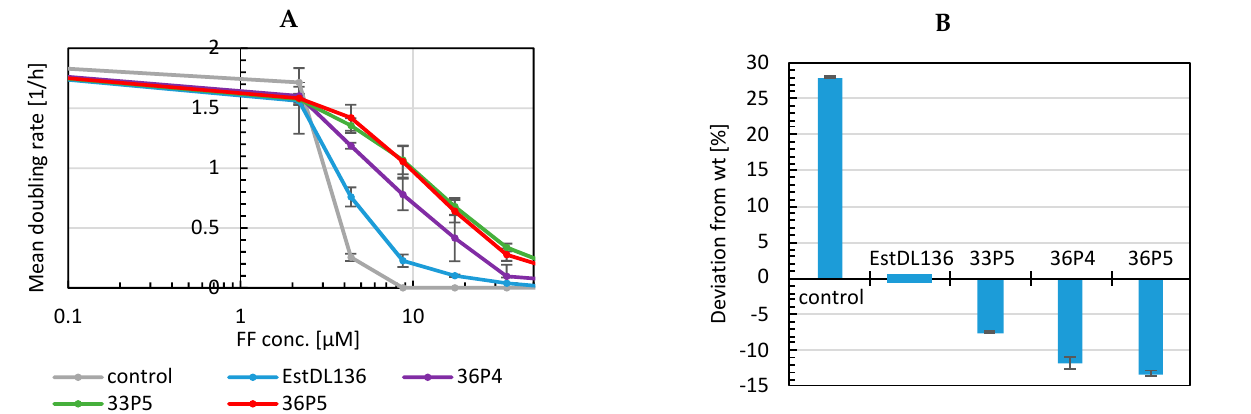
Figure 3. Growth assay of E. coli expressing wild-type hydrolase EstDL136 and mutants after retrans- formation ( A ) Comparison of selected mutants in liquid media containing different FF concentration ( n = 5 (EstDL136); n = 4 (33P5, 36P4); n = 6 (36P5); n = 2 (control = BL21 without plasmid)); ( B ) Inhibi- tion zone assay. The size of the inhibition zone was measured from scanned plates and calculated as a percentage deviation from cells expressing the wild-type hydrolase